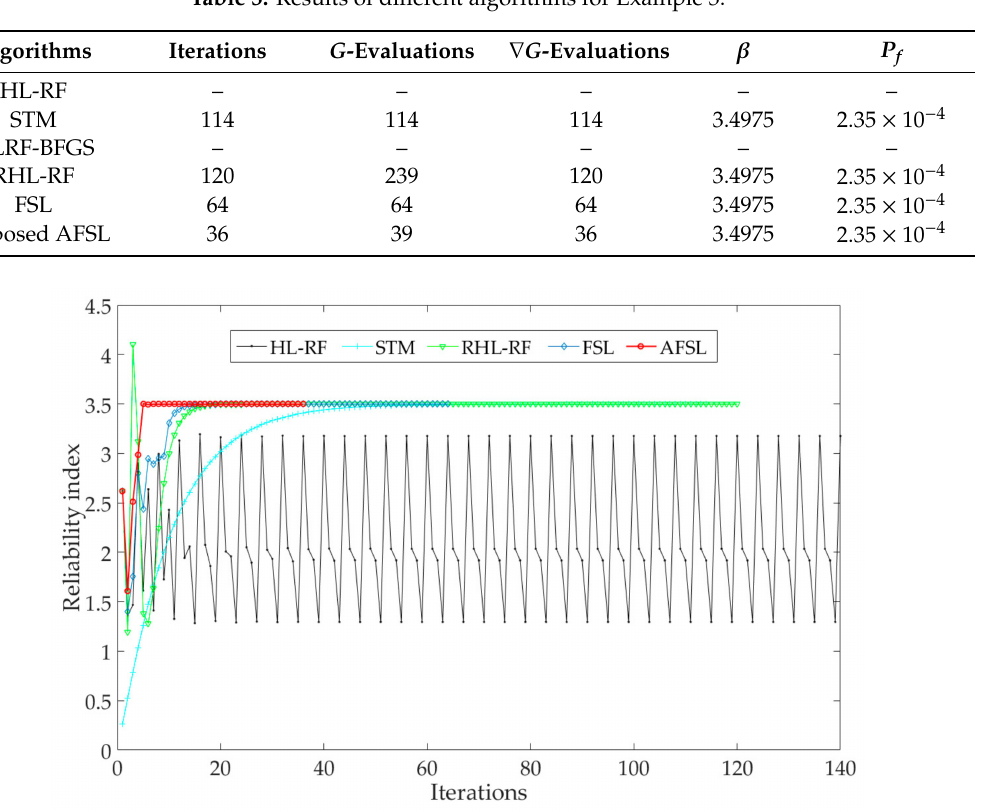
Figure 7. Iterative processes of reliability index for Example